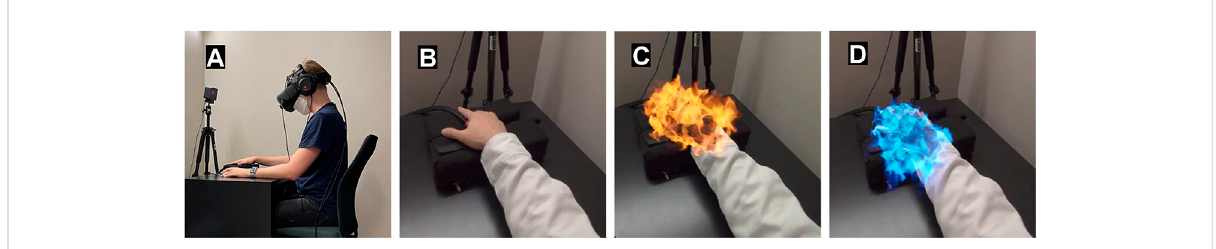
FIGURE 1 The experimental setup and the three experimental conditions: the participant sees the graphics covering their hand through the AR headset. (A) SideviewoftheparticipantwearingtheARheadset,leftarmoveracomputermouse,rightarmrestingonacushion,withthethermalstimulatorin contact with the thenar prominence of the right hand. (B) Baseline condition. Participant is looking through the headset on their right hand with no additional auditory and visual stimuli. (C) Fire condition, experiencing their own hand engulfed in a highly realistic simulation of fl ames. (D) Blue condition, experiencing somewhat fl ame like visuals covering their hand, but with a “ cool ” blue color and falling rather than rising